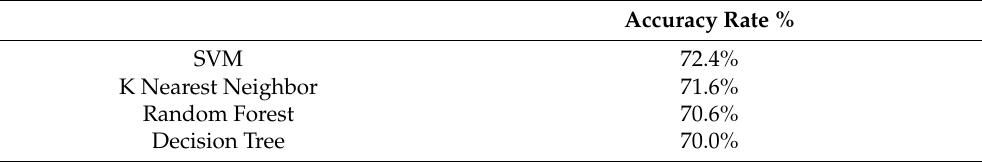
Table 5. Overall success of SECS—second scenario (by using estimated Euler angles).